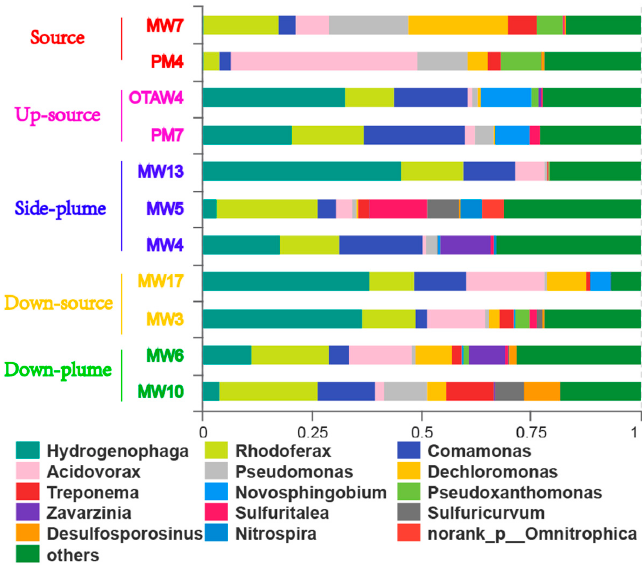
Figure 2. Bar chart of community abundances (greater than 5%) at the genus level.